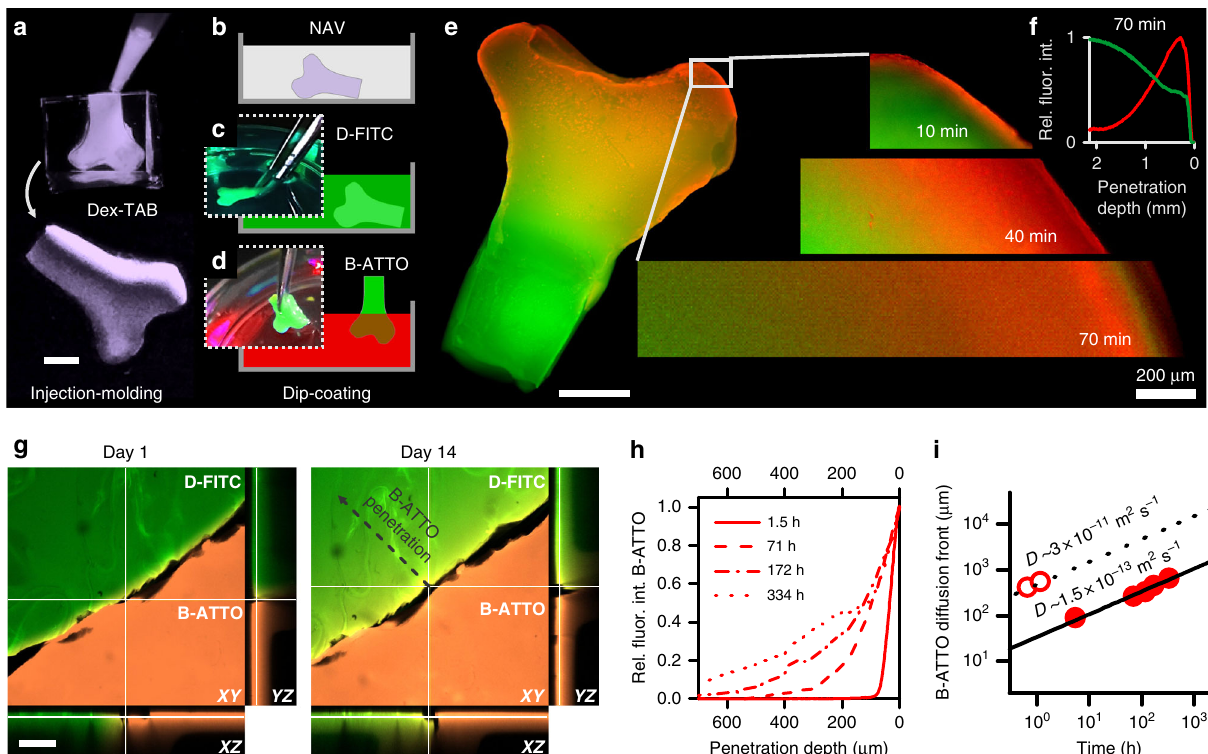
Fig. 3 Spatiotemporal control over injectable 3D hydrogel. a – f Diffusion-controlled displacement of D-FITC bound to neutravidin (NAV) by B-ATTO using a dip-coating method revealed the spatially controlled modi fi cation of a bone-shaped injection-molded biomaterial. The smooth, conformal, and contra- directional biochemical gradients could span up to several millimeters by controlling the diffusion of competitively binding biotinylated moieties. Scale bars indicate 2mm, unless otherwise indicated. g The stability of supramolecular biotin/NAV/desthiobiotin and biotin/NAV/biotin complexation within Dex-TAB was assessed by confocal time-lapse analysis of a fl uorescently patterned hydrogel construct. Scale bar indicates 200 µ m. h D-FITC did not displace B- ATTO, but B-ATTO could replace or occupy D-FITC-labeled Dex-TAB, as revealed by the progressively moving B-ATTO diffusion front. i The measured diffusion of B-ATTO in Dex-TAB during functionalization (open circles) matched with its theoretically predicted diffusion (dashed line; D = 3 ×10 − 11 m 2 s − 1 ). The moving front of B-ATTO after complexation to Dex-TAB (closed circles) was approximately 200 times slower than the diffusion of unbound B-ATTO as revealed by overlaying a theoretical plot (solid line) based on D = 1.5× 10 − 13 m 2 s − 1 . All green data indicate D-FITC. All red data indicate